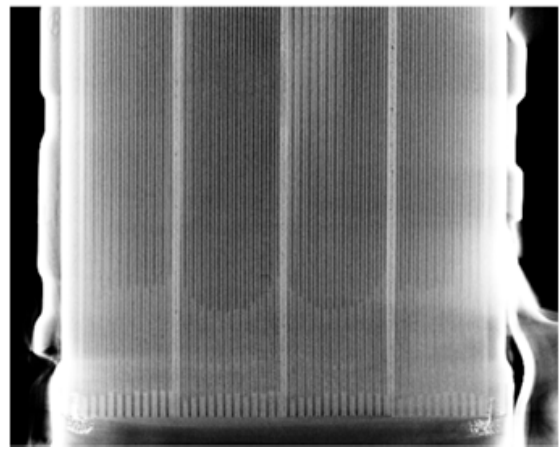
Figure 3. CT X-ray image of aged DPF.